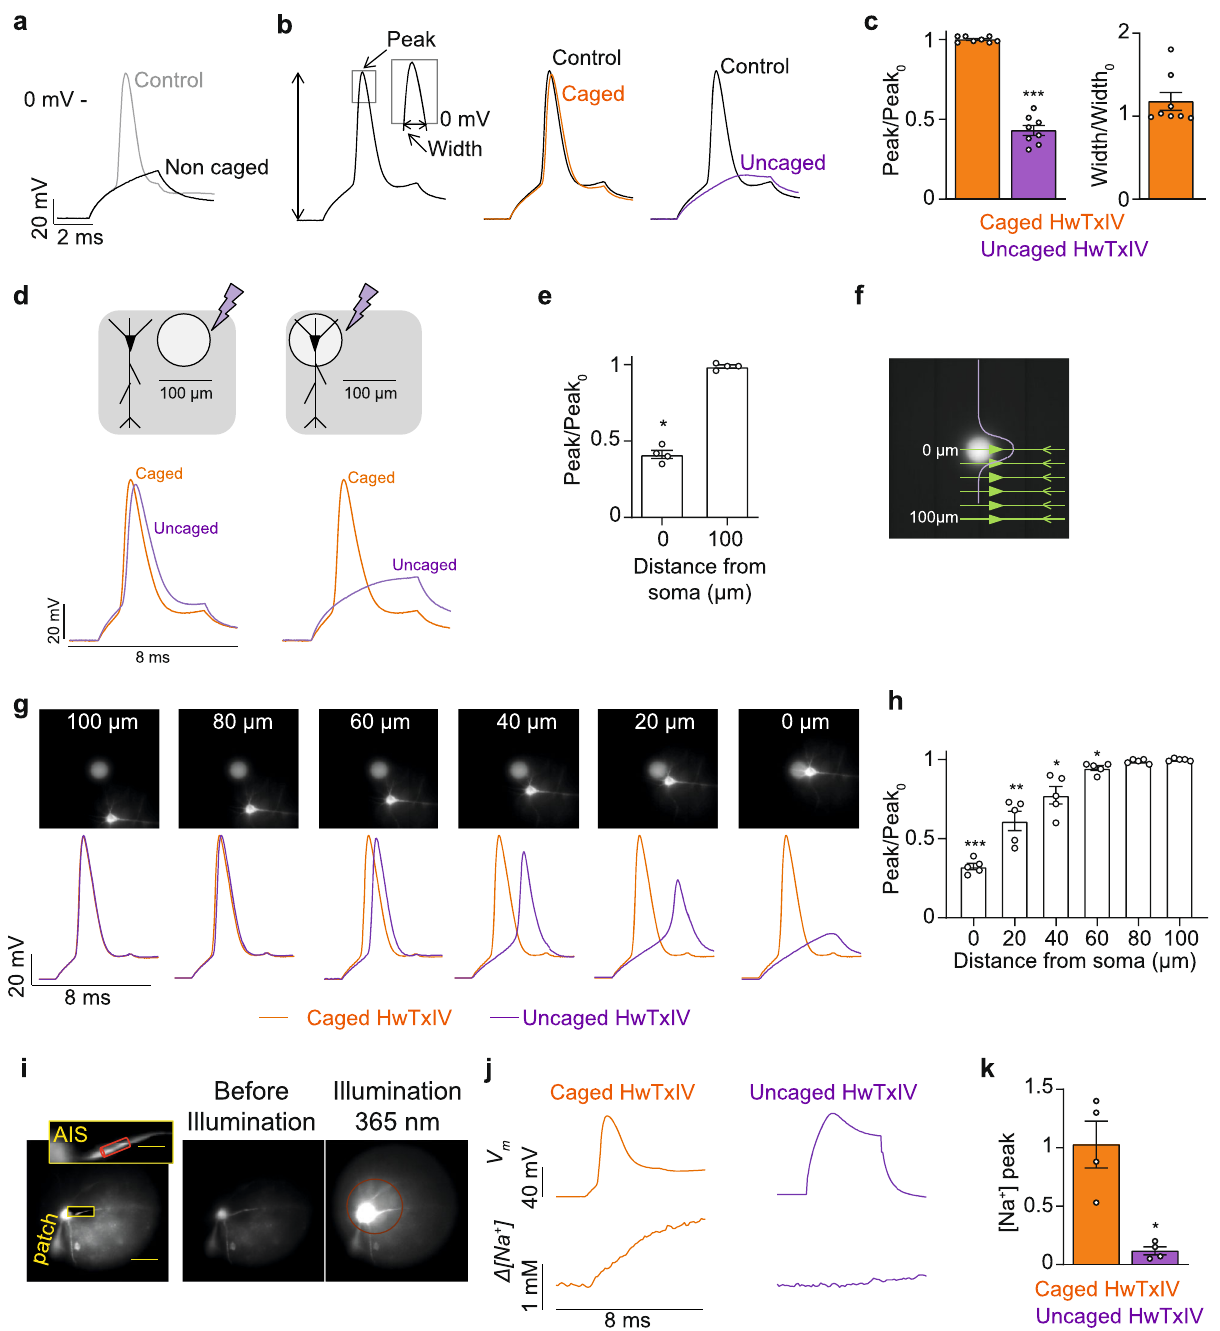
Fig. 5 Control of brain slice L5 pyramidal neurons by HwTxIV-Nvoc. a Inhibition of AP by 500 nM non-caged HwTxIV ( n = 6). b AP in control condition, in presence of 2.5 µ M HwTxIV-Nvoc and 1 min after uncaging. c Left: mean ± SEM ( n = 8 cells) of normalized AP peak after addition of HwTxIV-Nvoc and 1 min after photolysis (* p = 0.0078, two-sided paired t test). Right: mean ± SEM ( n = 5 cells) of normalized AP width after addition of HwTxIV-Nvoc. d APs 1 min after HwTxIV-Nvoc uncaging over a spot centered ~100 µ m from the cell body or over the soma. e Mean ± SEM ( n = 4 cells) of the normalized AP peak after uncaging 100 µ m away from the soma or directly on the soma. (* p = 0.0005, two-sided paired t test). f Image of the ~40 µ m diameter UV spot. Purple curve represents the light intensity pro fi le on cell schematic. g Top: images of a L5 pyramidal neuron relative to UV (405 nm) illumination spot position. Bottom: AP in the presence of HwTxIV-Nvoc (orange traces) and 1 min after uncaging (purple traces) with cell positioned at 100, 80, 60, 40, 20, and 0 µ m distance from spot. h Mean ± SEM ( n = 5 cells) of normalized AP peak 1 min after uncaging with the cell positioned at decreasing distances from spot center (100 µ m; 80 µ m, p = 0.2302; 60 µ m, * p = 0.0434; 40 µ m, * p = 0.0420; 20 µ m, * p = 0.0133; 0 µ m, *** p < 0.0001). Two-sided paired t -test. i Left, L5 pyramidal neuron fi lled with 500 µ M of ING-2. AIS area of Δ [Na + ] measurement in red cylinder. Right, images before and during UV uncaging pulse illustrating photolysis area. j Left, somatic AP (top) and associated Δ [Na + ] signal in the presence of HwTxIV-Nvoc. Right, after toxin uncaging, the cell was depolarized to + 20 mV to correspond to control AP peak and measure Δ [Na + ] signal in the same condition. k mean ± SEM ( n = 4 cells) of the Δ [Na + ] signal maximum (peak) before and after uncaging the toxin. (* p < 0.0174, two-sided paired t -test). Source data are provided as a Source Data File.